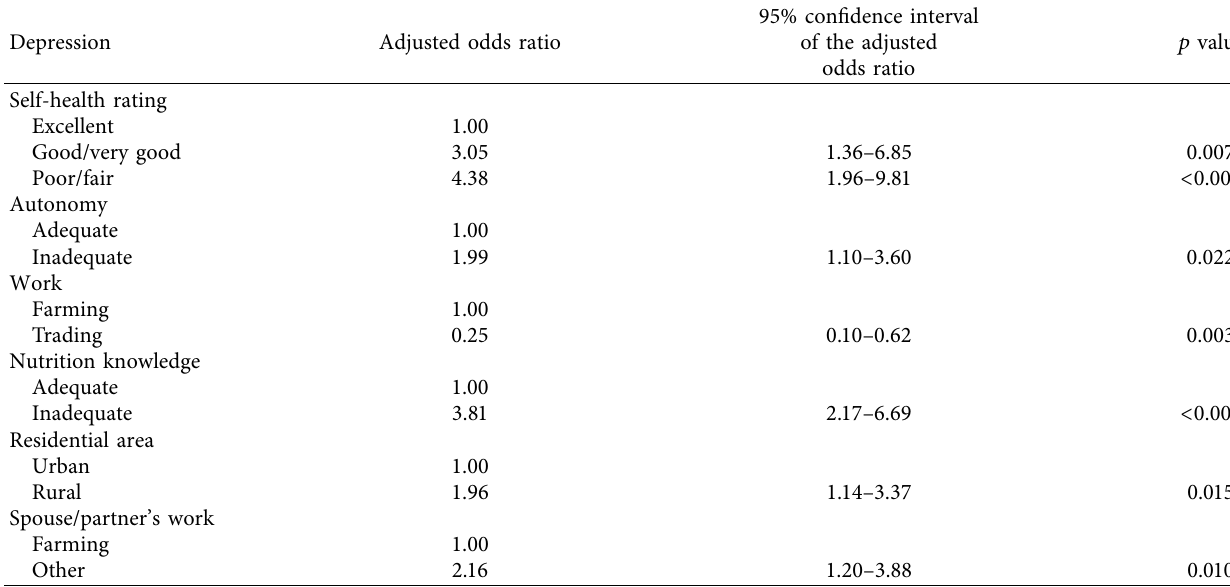
Table 3: Determinants of